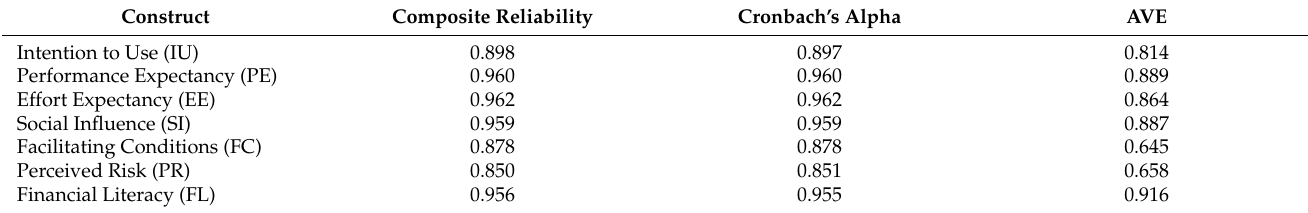
Table A3. Construct reliability, Cronbach alpha and convergent reliability.